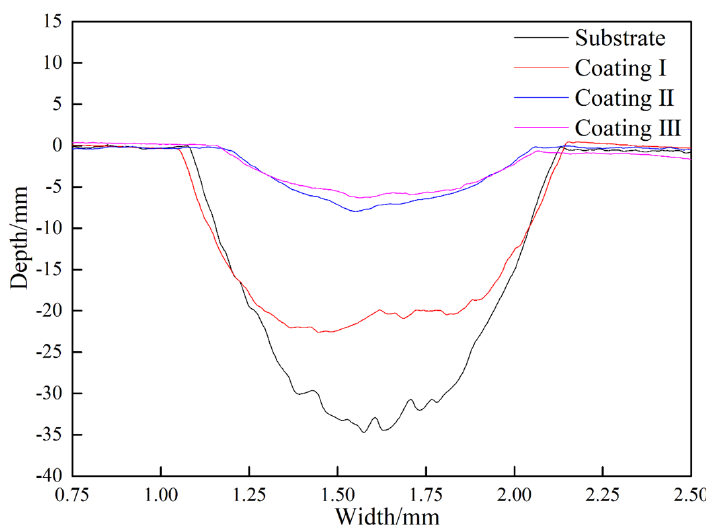
Figure 10. Worn profiles of the substrate and the coatings subject to friction in 3.5 wt.% NaCl solution. Table 6. Comparison of wear rates of high-entropy alloy coatings in corrosive solutions between our work and the relative references.